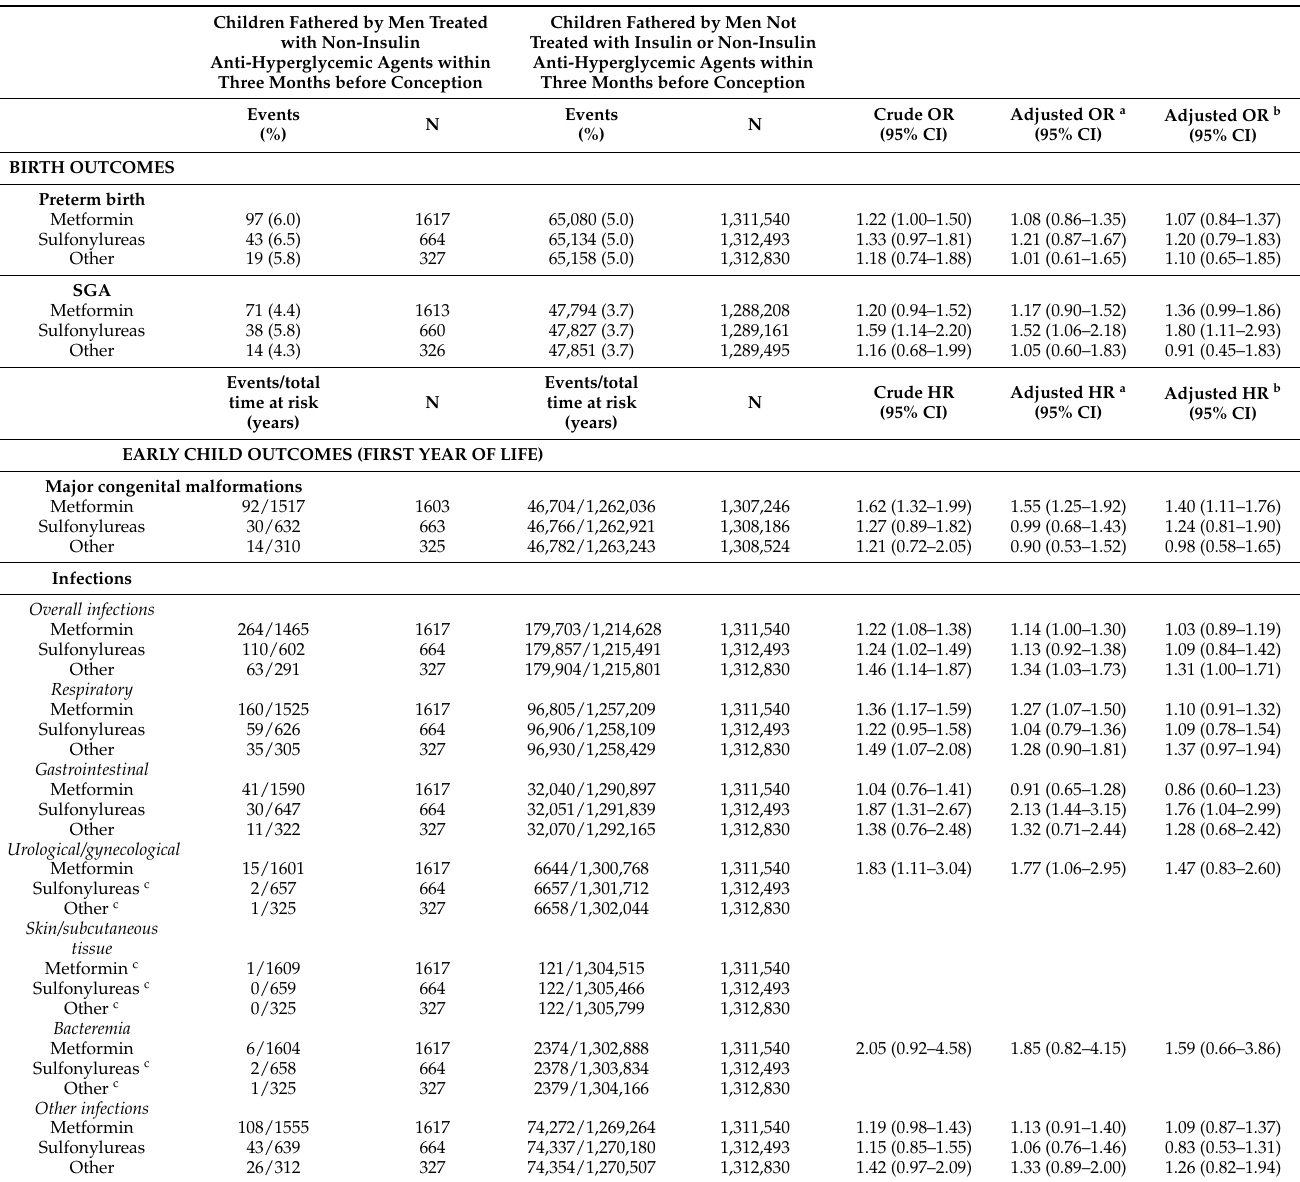
Table 3. Crude and adjusted odds ratio (OR), with 95% confidence interval (CI), for preterm birth and small for gestational age (SGA) in live born singletons fathered by men treated with non-insulin anti-hyperglycemic agents before conception, and the crude and adjusted hazard ratios (HR) for congenital abnormalities and early life infections in live born singletons fathered by men treated with non-insulin anti-hyperglycemic agents before conception. All analyses are stratified according to types of non-insulin anti-hyperglycemic agents (metformin, sulfonylureas,